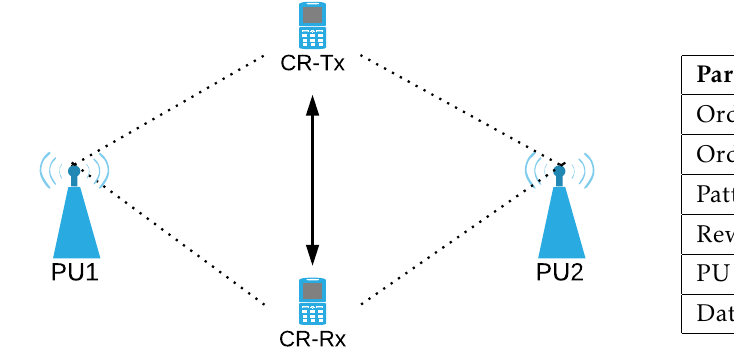
Figure 4. Simulated network scenario